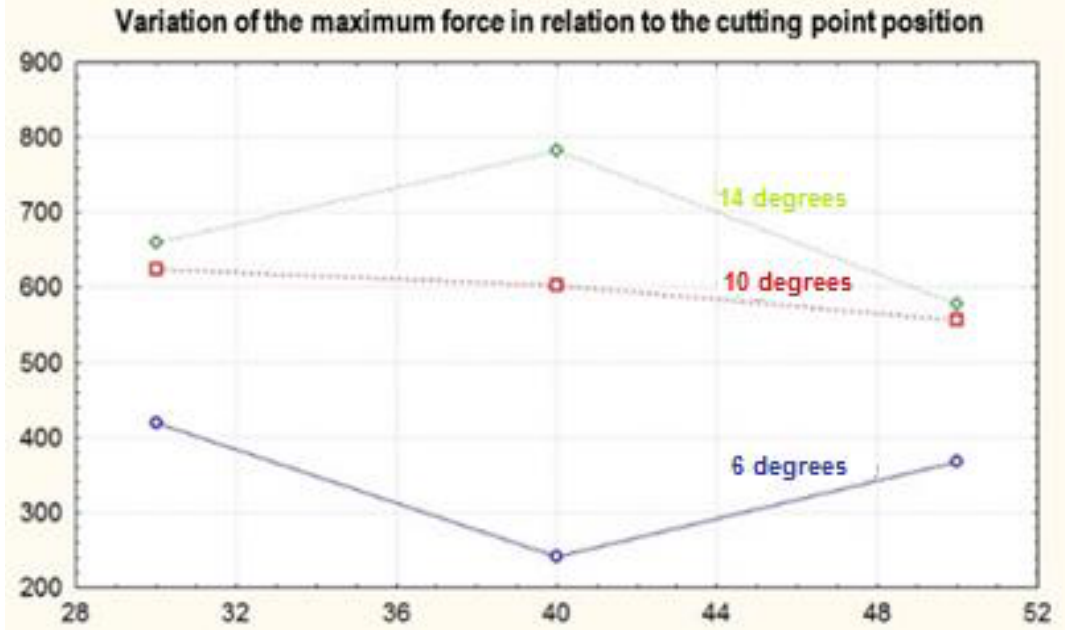
Figure 11. Variation of the maximum force in relation to the position of the cutting point.